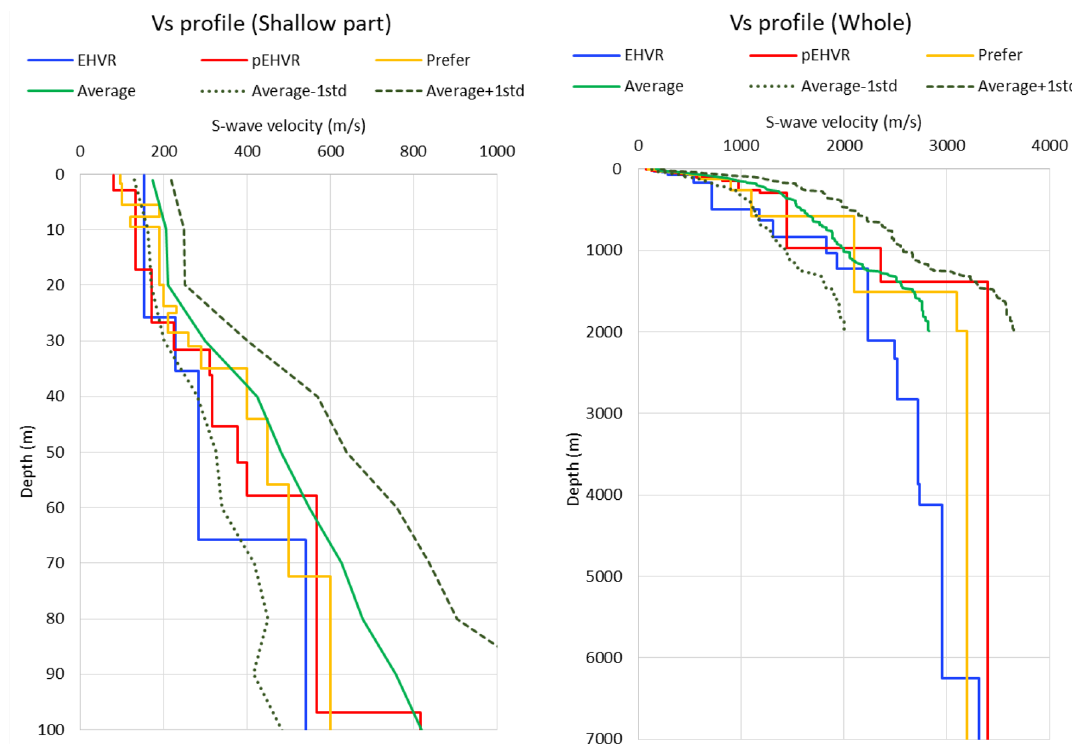
Fig. 8 Comparison of the inverted S-wave velocity profiles from pEHVR and EHVR with the average and average the predicted models in Step-1 (Chimoto et al. 2021). The orange line shows the profile of the preferred